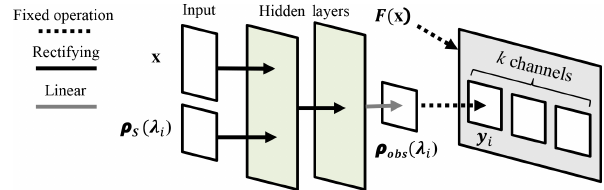
Figure 1. Illustration of a single subnetwork in the neural RTM em- ulator. Each subnetwork predicts the top-of-atmosphere reflectance ρ obs (λ i ) for a single channel centered at wavelength λ i provided state parameters x and surface reflectance ρ s (λ i ) . Collecting the predictions generated by k subnetworks, each modeling distinct channels, and converting those predictions from ρ obs to radiance emulates the RTM function F( x ) → y for the selected